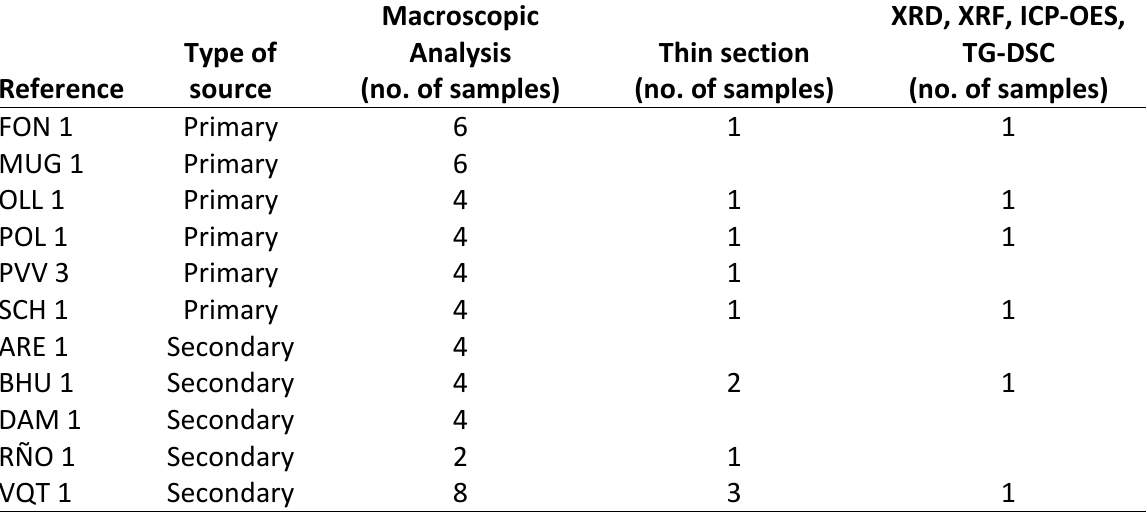
Table 1: Origin and samples studied according to the different analytical procedures used. The outcrops are located in Figure